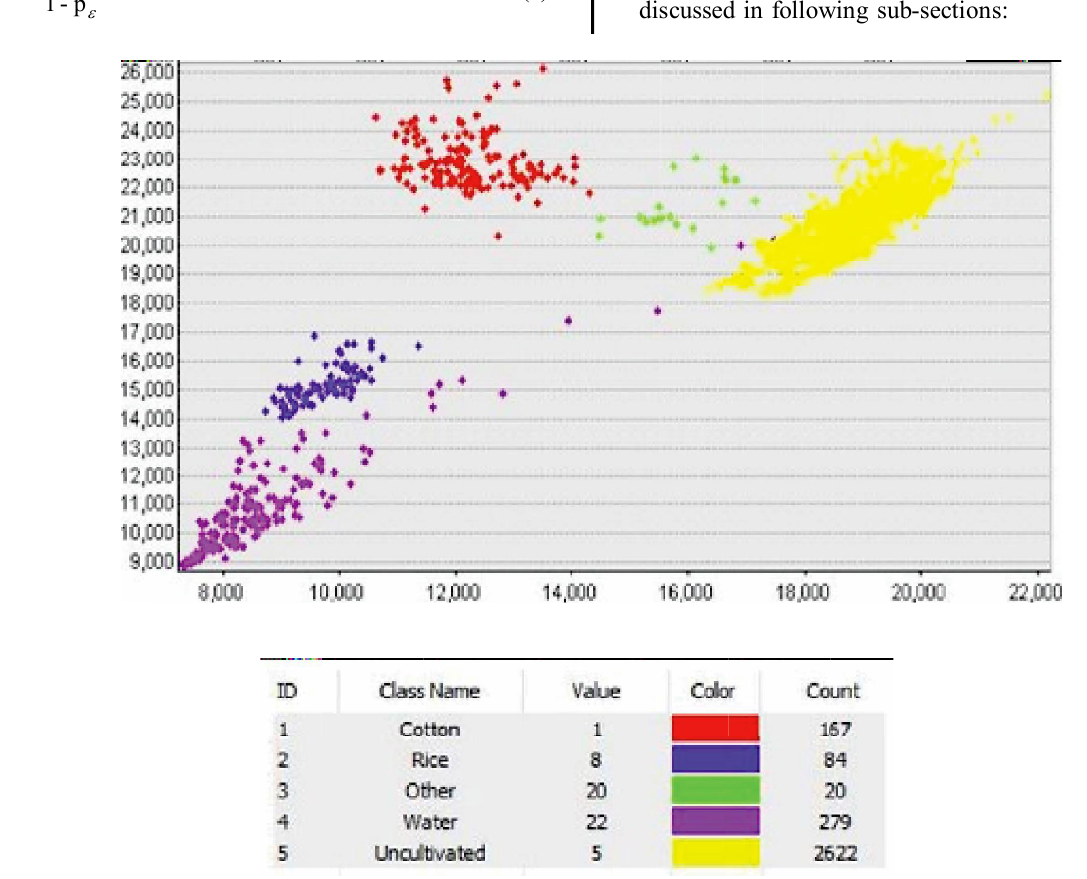
FIG. 3. DISTRIBUTION OF TRAINING DATA IN BANDS 3 AND 1, AND CLASSES OF TRAINING